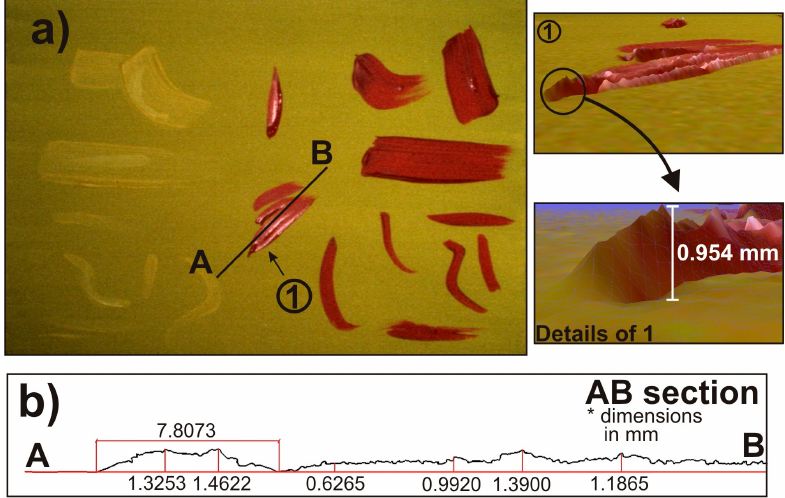
Figure 3. ( a ) Painting test sample. Detail of the 3DSDM of the painting (1) with the relief of the brushstrokes. Note the precision of the method in the inset, where a detail of a height of the brushstroke is 0.954 mm; ( b ) Geometrical details of an AB section of the brushstroke marked in ( a ). One can see the precision in the measurements of the 3DSDM of the sample, which can help to authenticate pictorial artworks